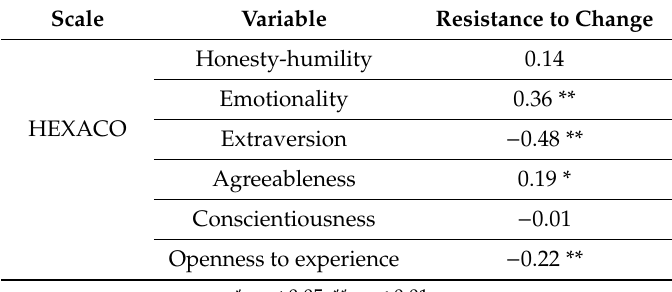
Table 2. Pearson correlation between personality traits and Resistance to Change